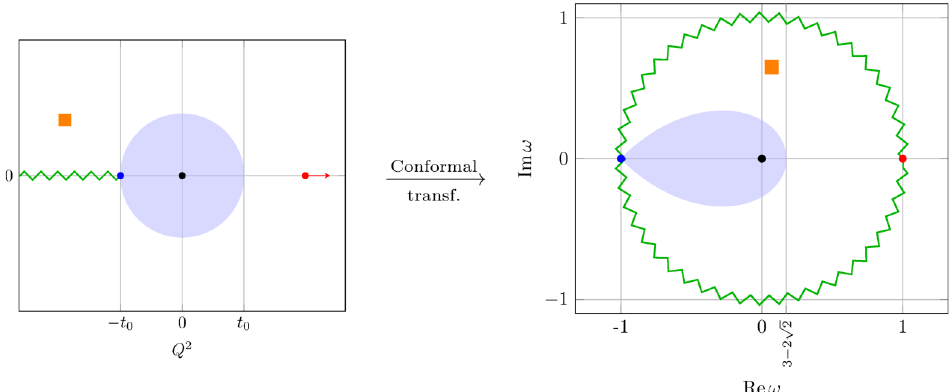
Figure 1 . Conformal mapping of the Q 2 -plane in the left into the ω -plane at the right. The green zigzag lines correspond to the branching cut Q 2 < − 1 . The black dot represents the Q 2 = 0 point t 0 on the left, mapped to ω = 0 on the right. The blue dot corresponds to the physical threshold: Q 2 = − t 0 on the left mapped to ω = − 1 on the right. The red dot is the limit Q 2 → ∞ on the left mapped to ω = 1 on the right. The zones in blue are the regions where | Q 2 | ≤ t in the Taylor 0 expansion of Π( Q 2 ) : the disc on the left is mapped to the blue domain in the ω -variable. The orange square shows how an arbitrary point in the complex Q 2 -plane is transformed in the ω